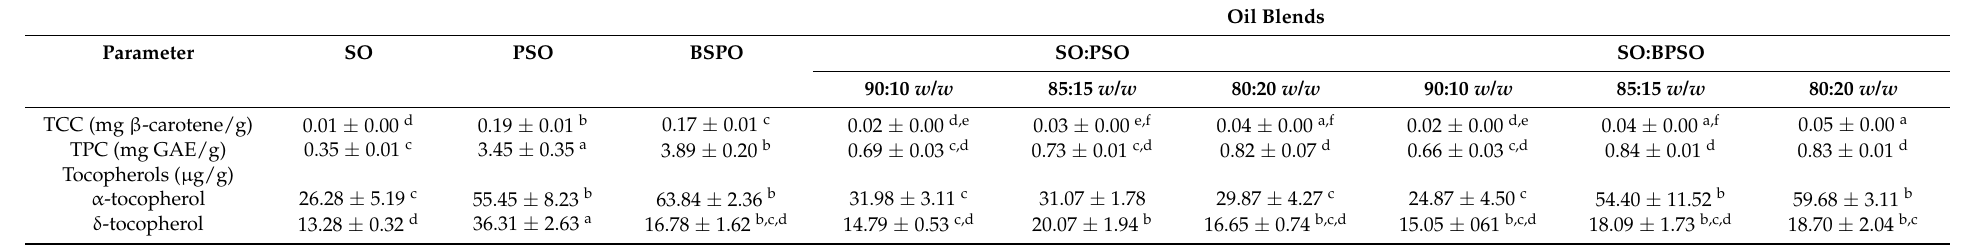
Table 2. Total phenolic content (TPC), total carotenoids content (TCC), and tocopherols of sunflower oil, pomegranate seed oil, and oil blends.